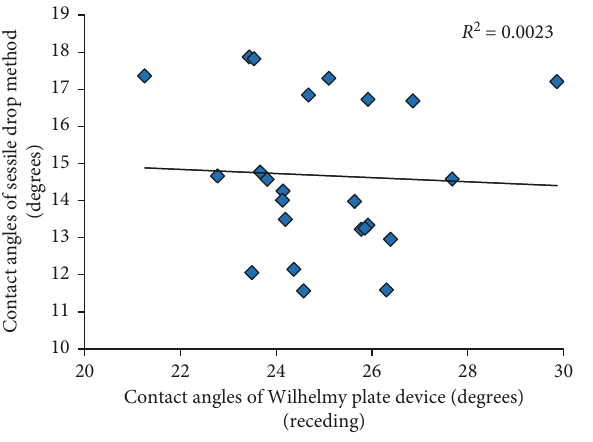
Contact angles of Wilhelmy plate device (degrees) (receding) Figure 6: Correlation between contact angles (receding).